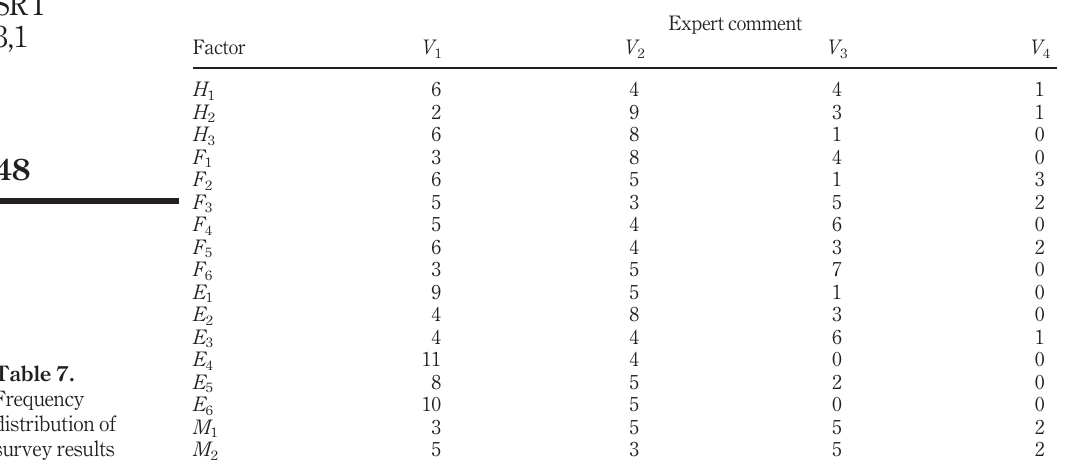
distribution of survey results